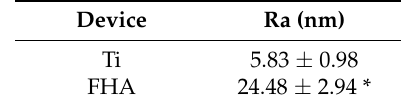
Table 1. Roughness values of Ti and FHA implant materials.